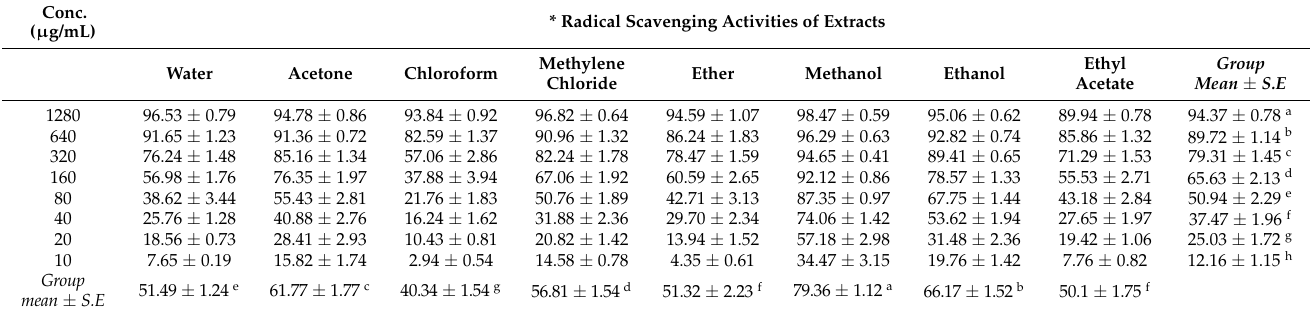
Table 1. Radical scavenging activity of Solenostemma argel extracts at different concentrations toward DPPH. Conc. ( µ g/mL) * Radical Scavenging Activities of Extracts